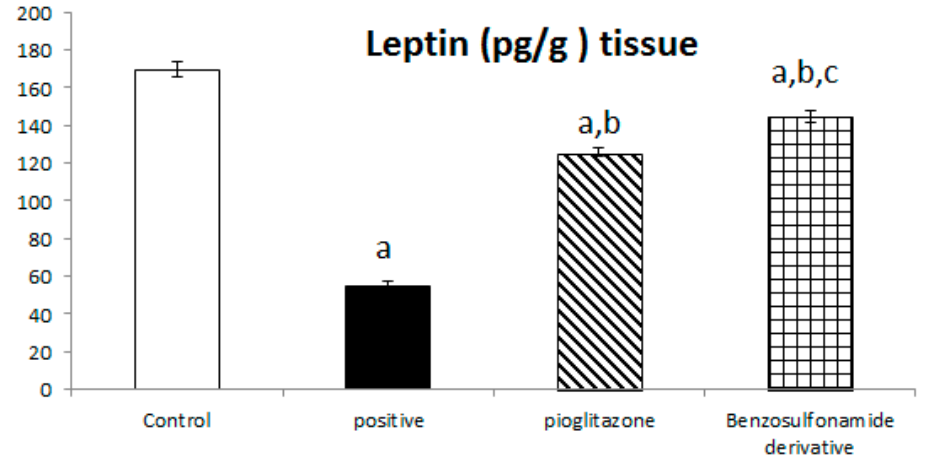
Figure 5. Bar chart presentation of liver tissue GLP-1 and leptin concerning the effect of 14 days of oral administration of the synthetic compound against the reference anti-hyperglycemic pioglitazone on STZ-induced type 2 DM. DM: diabetes mellitus. Each bar represents the mean of 6–8 values ± the standard error of the mean (S.E.M). a: Significantly different from the normal control group, b: Significantly different from the positive control group, c: Significantly different from the pioglitazone group at p < 0.05.